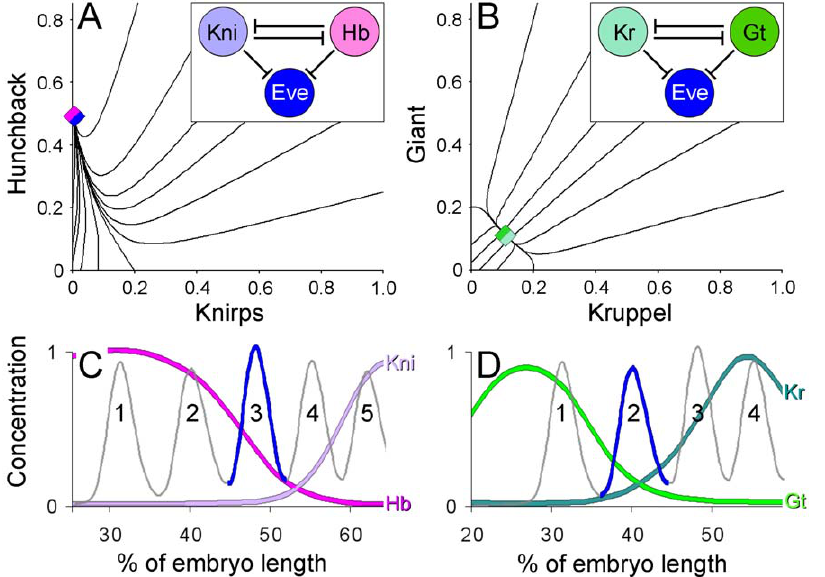
Figure 5. Mutually repressive gradients position pair-rule stripes. (A, B) Phase portraits of monostable toggle switches (as in Figure 2), analogous to gradient pairs establishing expression of Eve stripes (see the network motifs). (C) Formation of the Eve stripe 3 (as well as the Eve stripes 4, 6, 7) requires specific ratio between the Hb and Kni concentrations. (D) Formation of the Eve stripe 2 (as well as the Eve stripe 5) requires specific ratio between the Gt and Kr concentrations. Gradients in (C) and (D) are color-coded in accordance with the network nodes in (A) and (B). Notice, every Eve stripe requires a combination of inputs present in either of the toggle switches (e.g. either Hb + Kni or Gt + Kr).